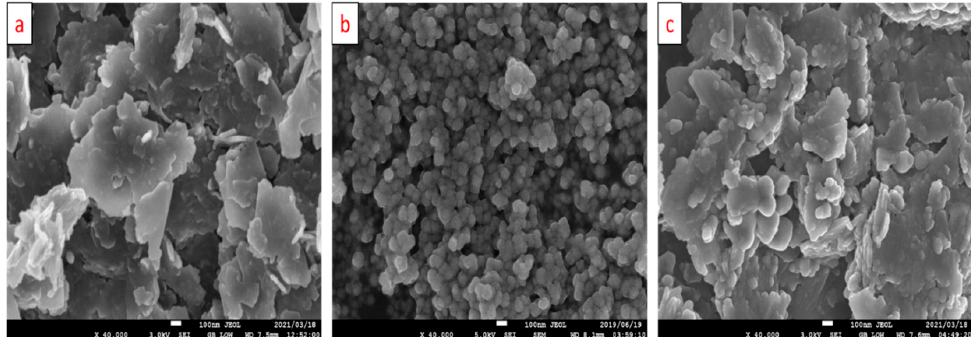
Figure 2. HR-SEM images of RGO nanosheets ( a ), MnO 2 nanoparticles ( b ) and the MnO 2 @RGO nanocomposite ( c ). The EDX elemental mapping and composition of RGO nanosheets (Figure S1) show the presence of C (84.04%) and O (15.96%) across the entire surface (Figure S1a–c), with no impurities on the EDX spectrum (Figure S1d). MnO 2 nanoparticles (Figure S2) display the presence of Mn (27.61%) and O (24.76%) distributed evenly across the entire surface (Figure S2a–c, with C (47.38%) observed in the EDX spectrum from coating of the material, alongside traces of Al (0.14%) and Cl (0.11%) (from the sample stubs and remains from